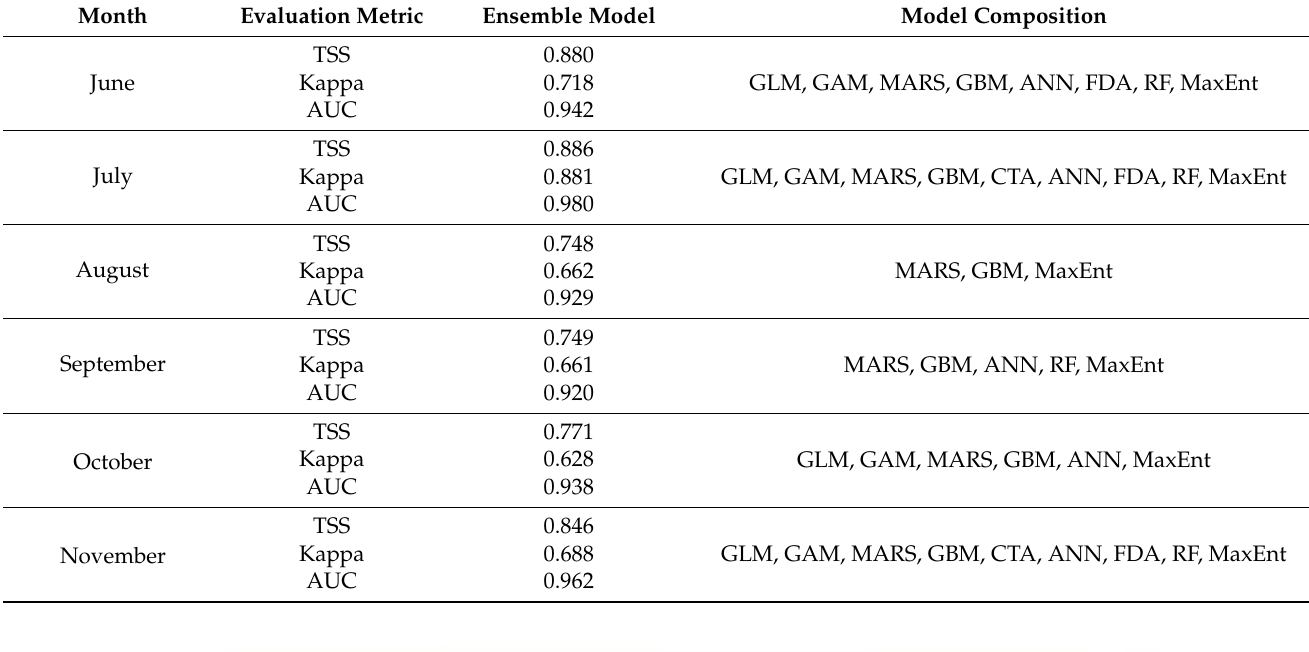
Table 5. Evaluation metrics and model compositions for the ensemble models.